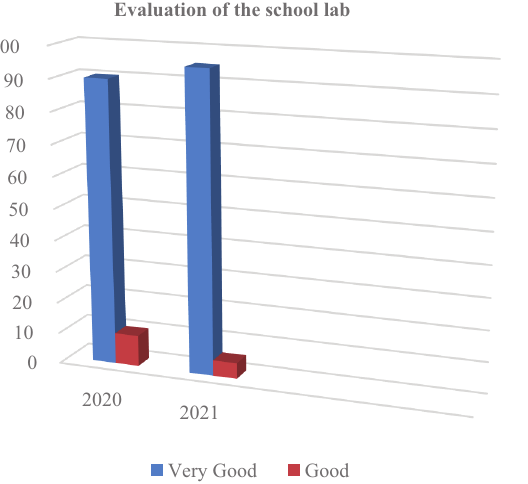
Fig. 7. Anonymous evaluation by students of the “Particle Accelerators and Detectors” lab